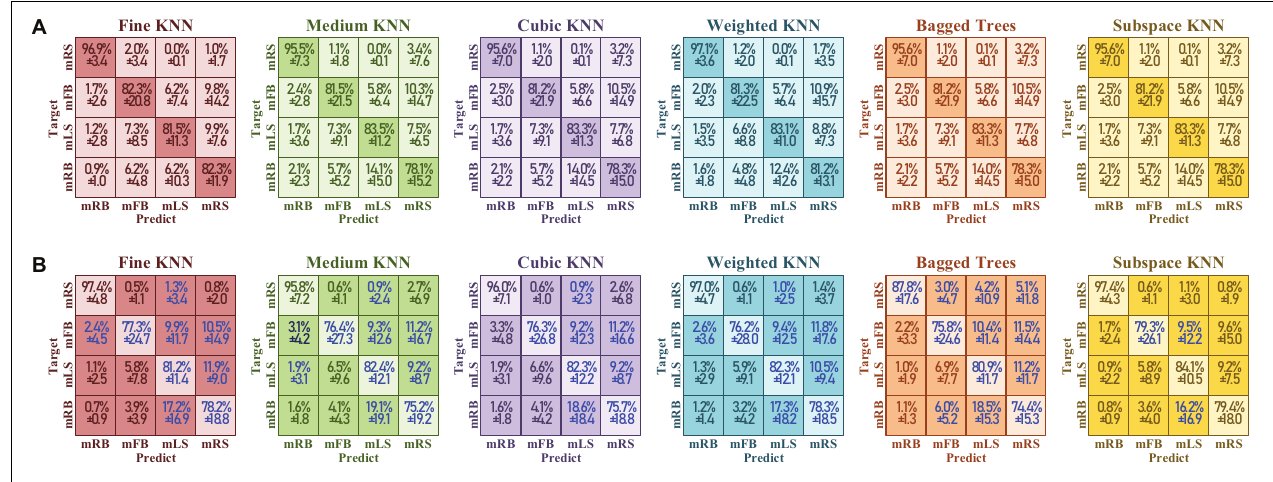
FIGURE 20 | The confusion matrix of test accuracy under (A) training set with “fake EEGs augmented” versus (B) training set “only real EEGs.” The blue highlight represents that the performance has been improved with the simulation contained.